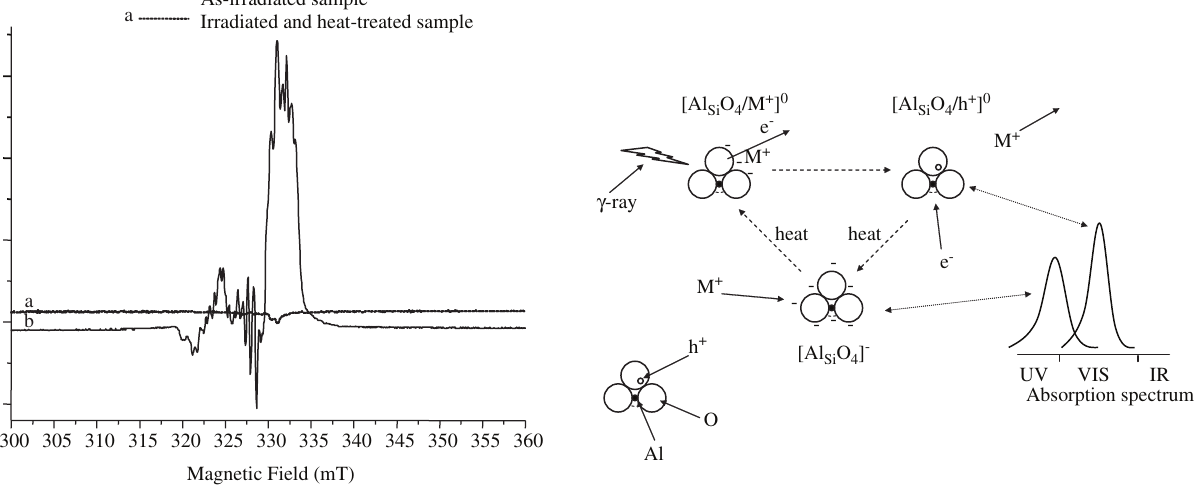
Figure 5. Mechanism of optical absorption in gamma irradiated and heat- treated natural quartz.